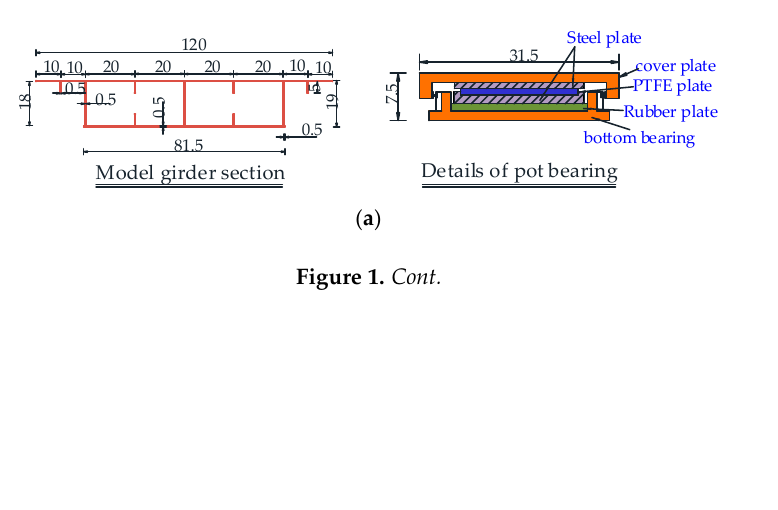
Table 1. Similarity ratio of the test.